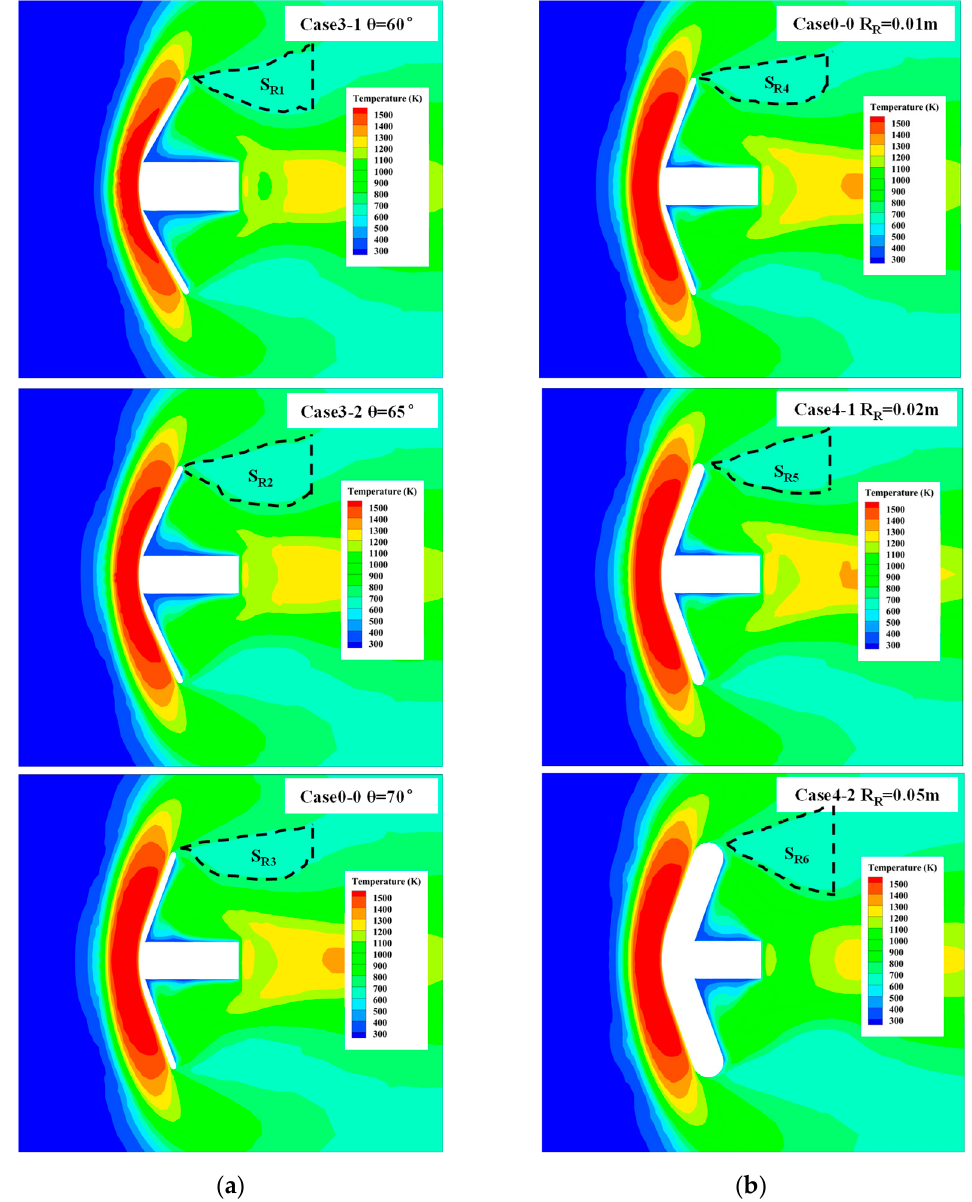
Figure 12. Temperature contours of case 0-0, case 3-1 to case 4-2: ( a ) θ is changed; ( b ) R R is changed.